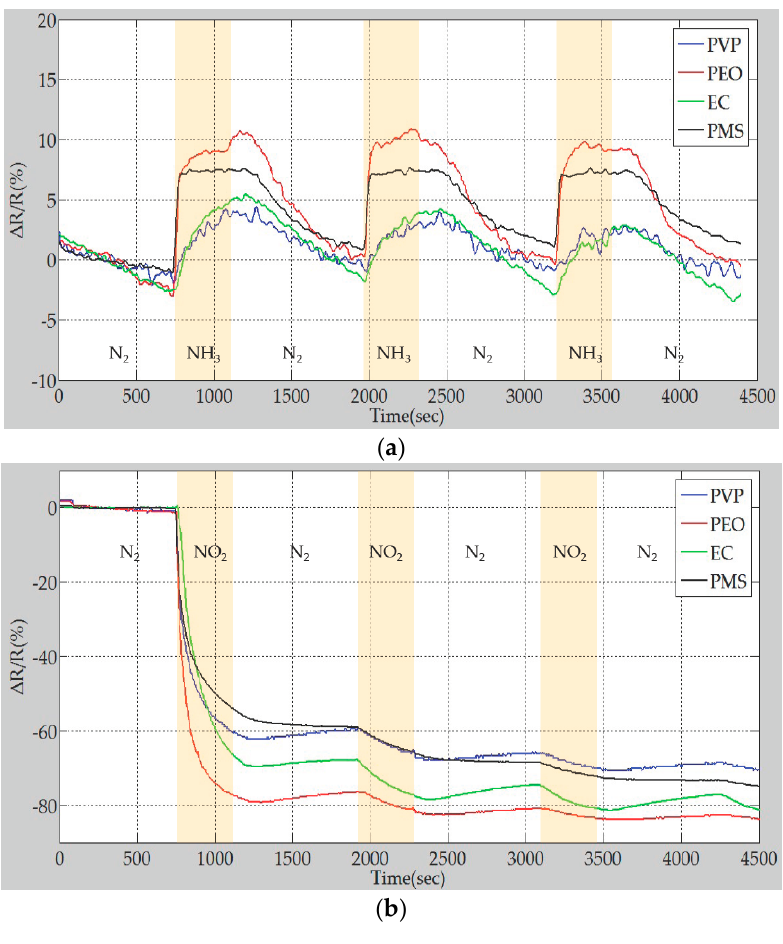
Figure 12. Repeatability test of gas sensor array using different gases. ( a ) Response of the gas sensor array to 1000 ppm NH 3 ; ( b ) Response of the gas sensor array to 1000 ppm NO 2 .